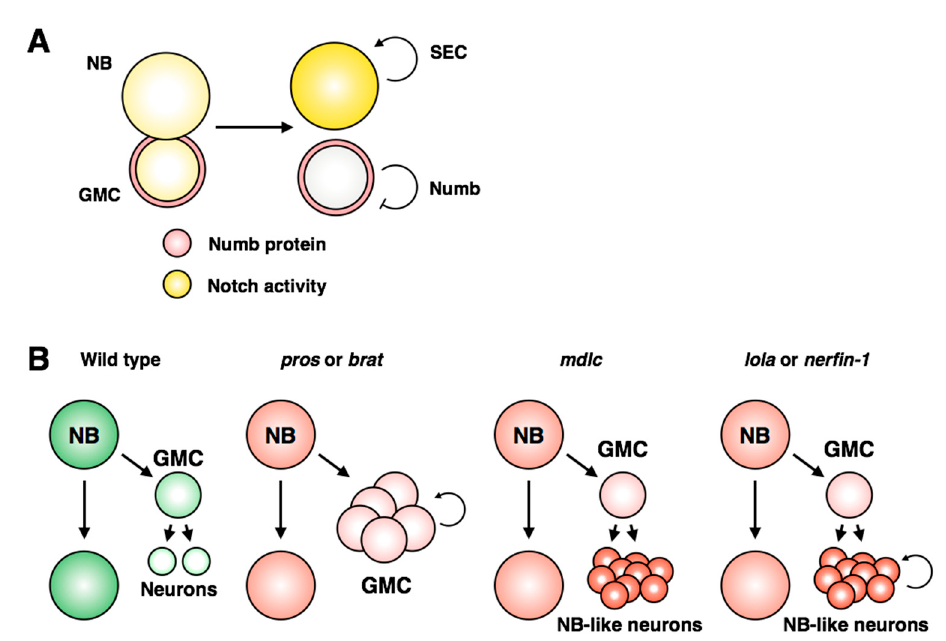
Figure 9. Misregulation of stem cell and differentiated cell identity. ( A ) Notch activity is detected equally in the stem cell and GMC following neuroblast division, but quickly becomes restricted to the neuroblast [128]. The super elongation complex (SEC) promotes a positive feedback loop with Notch signaling in the neuroblast, while Numb inhibits Notch specifically in the GMC. ( B ) Loss of differentiated cell identity can lead to unchecked proliferation in the nervous system. Two classes of dedifferentiation mutants have been identified: pros and brat mutants fail to restrict the GMC to a single terminal division, while mdlc , lola or nerfin-1 mutants display ectopic expression of neuroblast markers in neurons. lola and nerfin-1 mutants also result in ectopic proliferation of neuronal cells.